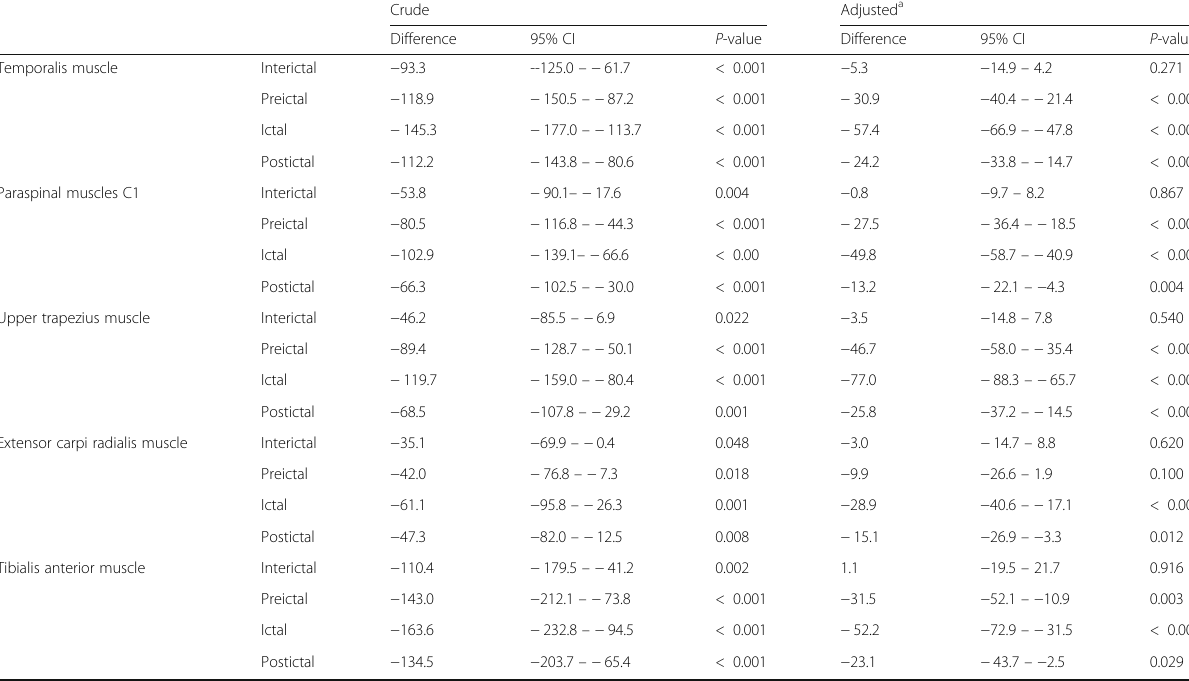
Table 5 Differences in pressure pain thresholds between people with migraine and healthy participants (non-dominant side)